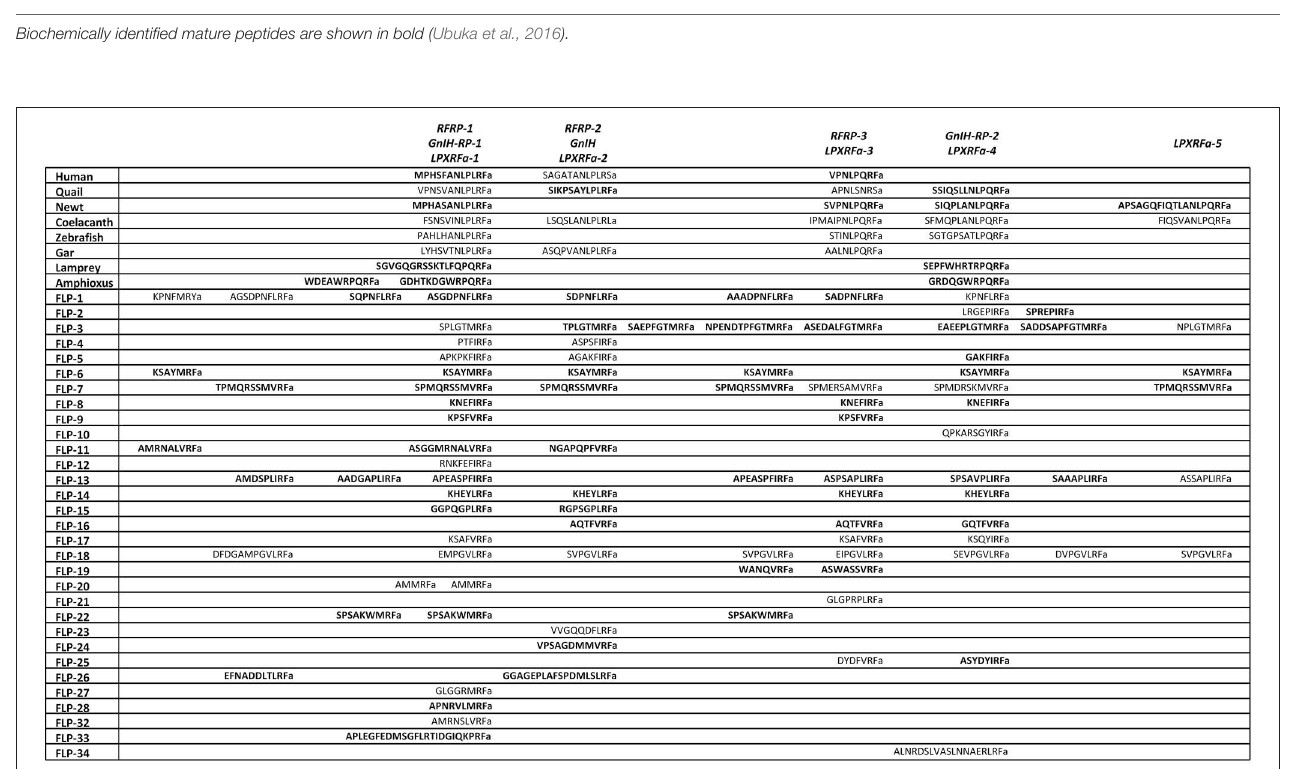
FIGURE 1 | A schematic representation of the multiple sequence alignment of human, quail, newt, coelacanth, zebrafish, gar, lamprey, amphioxus GnIH and C. elegans FMRFamide-like peptide (FLP) precursors highlighting the sequences of identified and predicted biologically active peptides. Human, quail, newt, coelacanth, zebrafish, gar, lamprey, amphioxus GnIH and C. elegans FLP precursor polypeptides were aligned by EMBL-EBI Clustal Omega Multiple Sequence Alignment software. The positions of the identified or predicted endogenous peptide sequences in their precursors are shown in bold or normal font, respectively. The full alignment of the precursors are shown in Supplementary Figure 1 . Accession numbers are human ( Homo sapiens ) GnIH precursor (NP_071433.3), Japanese quail ( Coturnix japonica ) GnIH precursor (XP_015709159.1), Japanese fire belly newt ( Cynops pyrrhogaster ) GnIH precursor (BAJ78290.1), West Indian Ocean